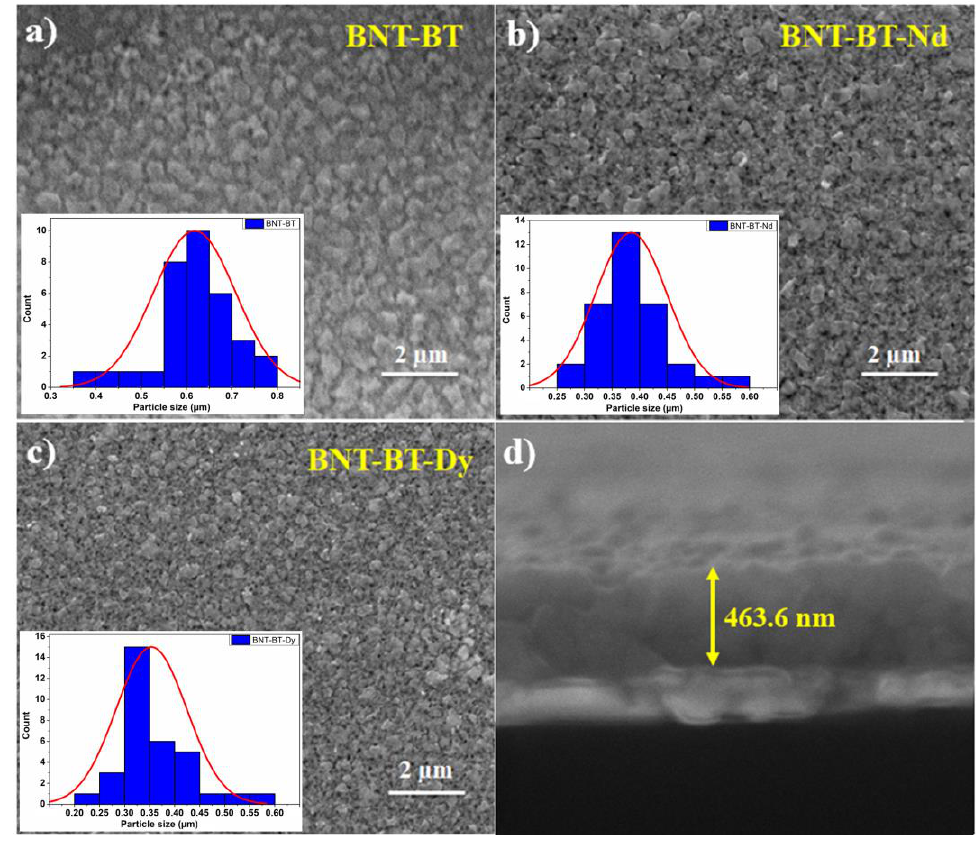
Figure 1. SEM images showing the microstructure of the investigated thin films: ( a ) BNT – BT, ( b ) BNT-BT-Nd, ( c ) BNT-BT-Dy, and ( d ) example of a cross-sectional image of the BNT-BT thin film.